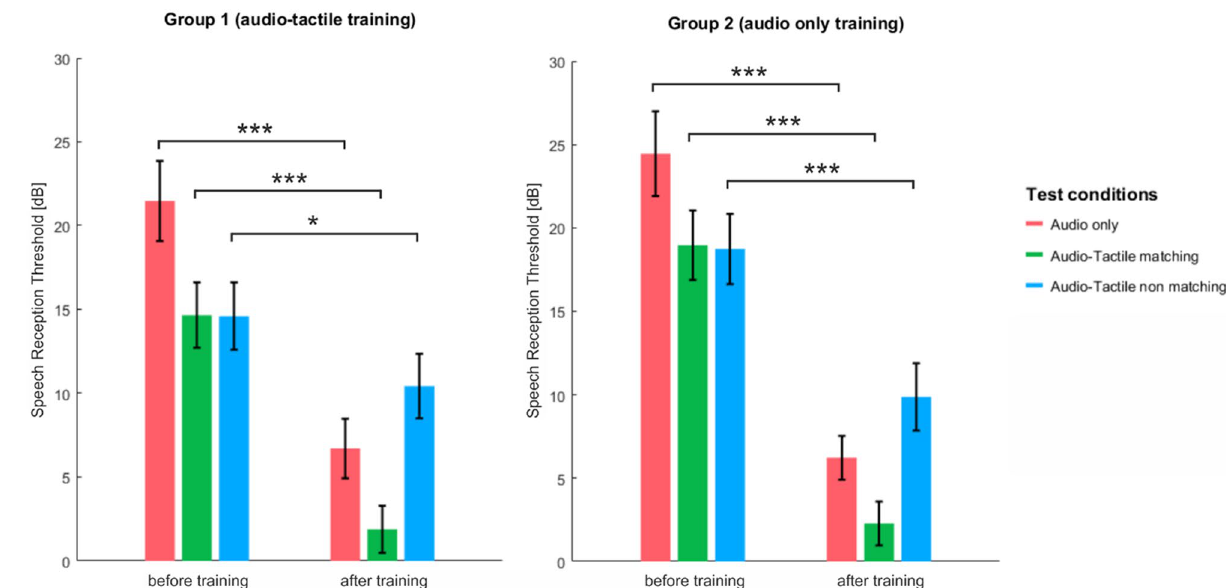
Figure 3. Speech reception thresholds in three test conditions before and after training in two groups separately; bars correspond to standard errors of the mean (Bonferroni, *indicates p < 0.017, **indicates p < 0.003, ***indicates p <